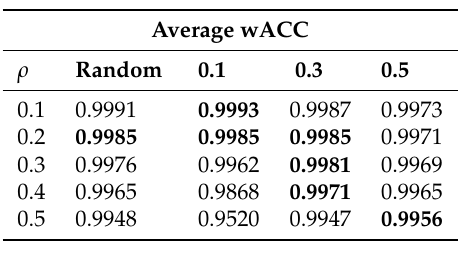
Table 5. Dependence of the noise density used during training using BSD500 dataset on the network performance and its ability to detect impulses in test images degraded with varying noise density. The best values are presented in bold font.